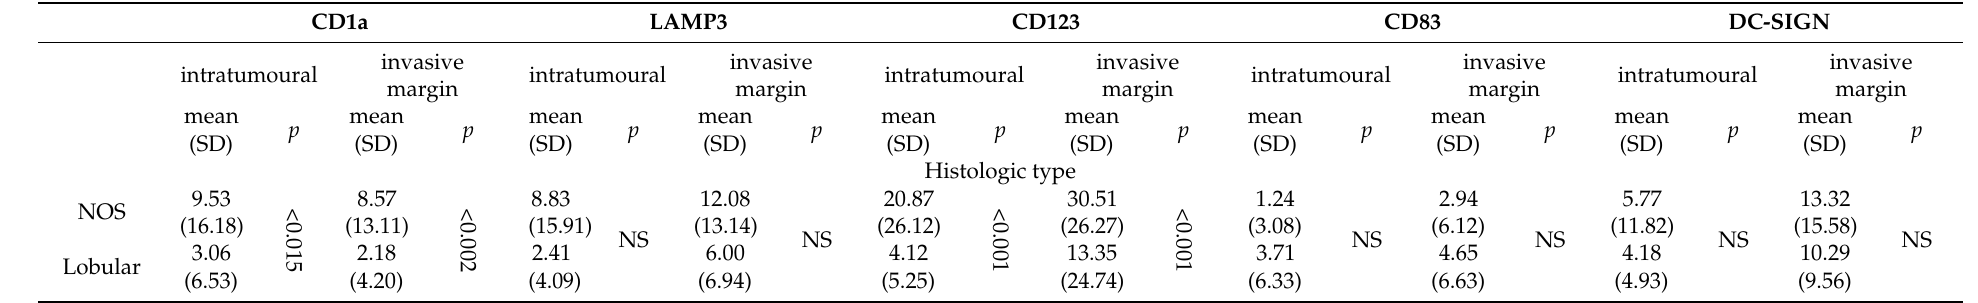
Table 6. DC density in breast cancers of different histologic